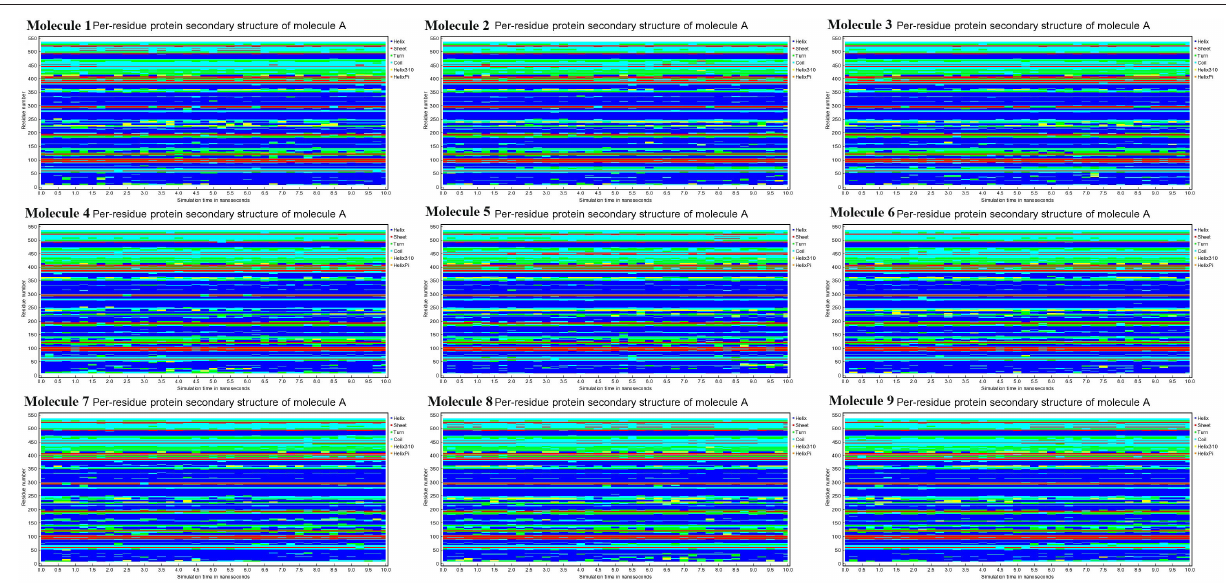
Frontiers in Medical Technology |